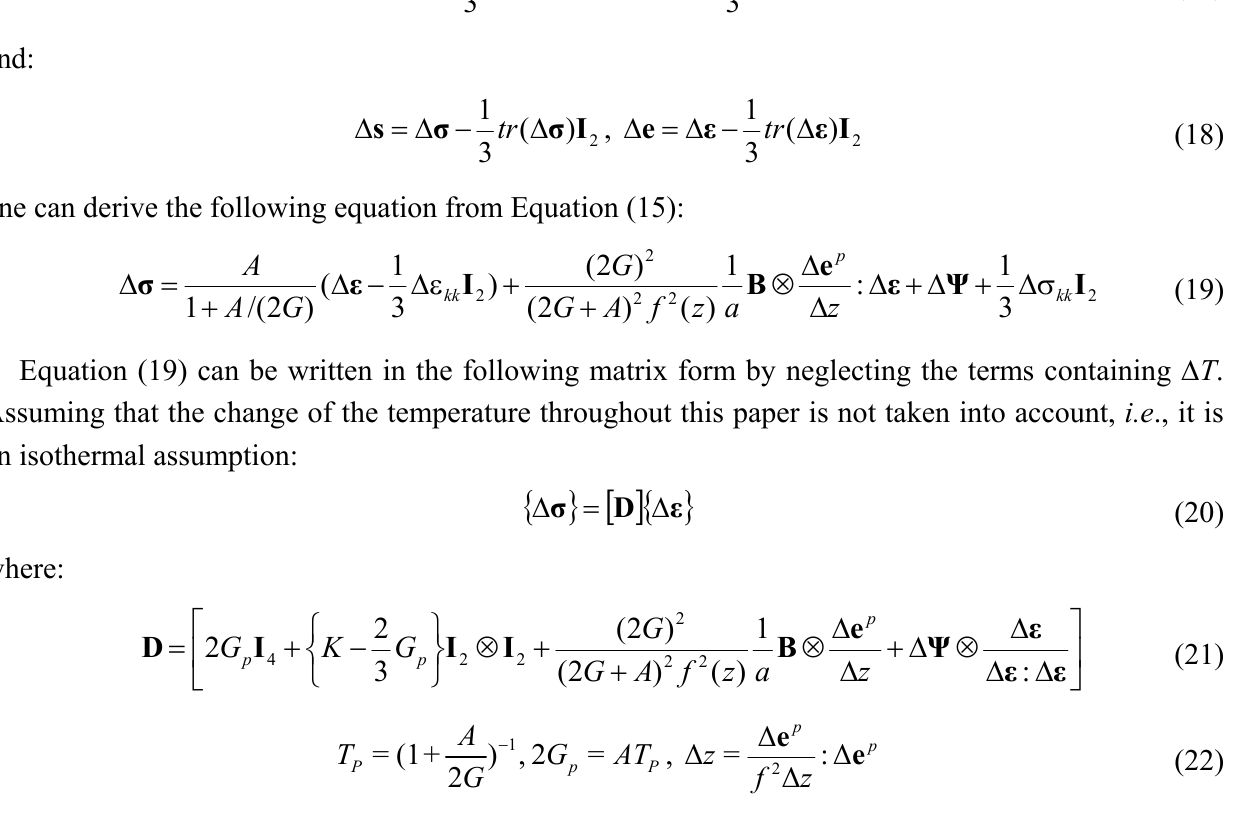
Austinite Austinite Martensite Martensite